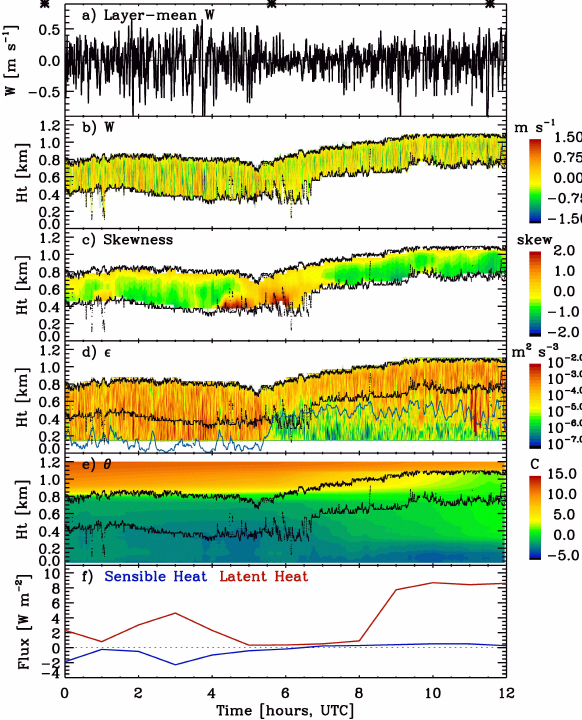
Fig. 3. Remote-sensor-derived cloud and atmosphere dynamical properties for 28 August 2008 (Case #1), including (a) layer-mean vertical velocity, (b) vertical velocity within the liquid cloud layer, (c) skewness of vertical velocity over running 30min windows, (d) turbulent dissipation rate, (e) potential temperature, and (f) sur- face turbulent sensible (blue) and latent (red) heat fluxes. Liquid cloud boundaries are given in black in the middle four panels, while the base of the cloud-driven mixed layer is given in blue in (d) . Launch times for radiosoundings in Fig. 4 are given as black stars along the top